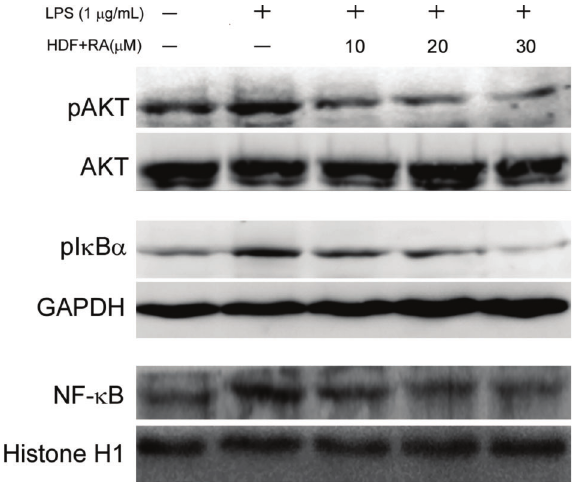
Figure 4. Hemodialysis fl uid (HDF) supplemented with rosmarinic acid (RA) increased phosphorylation of cytosolic AKT and I k B a and diminished nuclear NF- k B in lipopolysaccharides (LPS)- stimulated human umbilical vein endothelial cells. Phosphoryla- tion of cytosolic AKT and I k B- a , and the level of nuclear NF- k B were determined by immunoblot using speci fi c antibodies and chemiluminescence development. Levels of GAPDH and histone H1 were used as cytosolic and nuclear